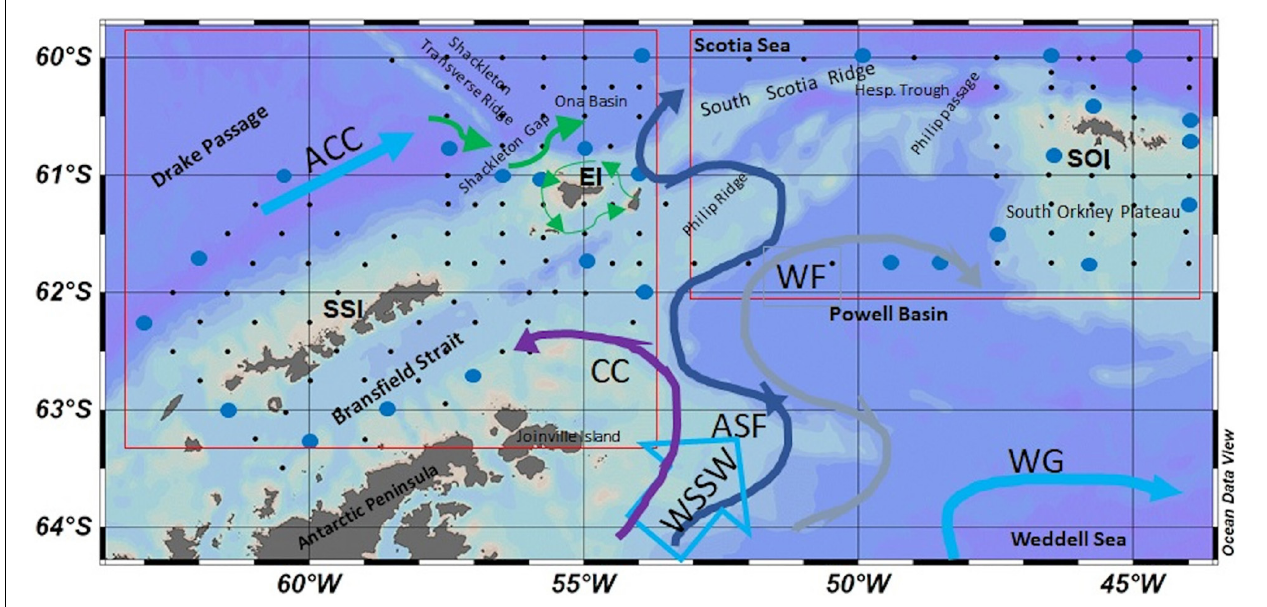
FIGURE 1 | Region of study surveyed in 2007 [South Shetland Islands (SSI) and Elephant Island area (EI)—left square] and 2008 [South Orkney Islands (SOI)—right square] with the most relevant geographical features. Between these two groups of islands, is located the Weddell-Scotia Confluence (WSC). Stations marked in blue are the 27 stations sampled for iron. Colored arrows represent the main schematic flows of the Antarctic Circumpolar Current (ACC), Weddell gyre (WG), together with main outflows of the Weddell Sea shelf waters (WSSW): The Coastal Current (CC purple), Antarctic Slope Front (ASF dark blue), and Weddell Front (WF gray arrow); based on Thompson et al. (2009). Green arrows represent the counter-clockwise circulation around EI, based on Ardelan et al. (2010) and Zhou et al. (2010). Graphs plotted with Ocean Data View (Schlitzer, 2016).